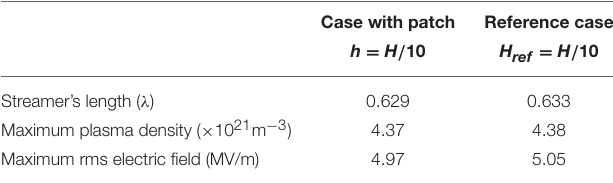
TABLE 2 | Streamer’s length (in units of λ ), maximum plasma density (in m − 3 ) and maximum rms electric field (in MV/m) at 110 ns for the case using the local patch and the reference case corresponding to conditions of Figure 7 .